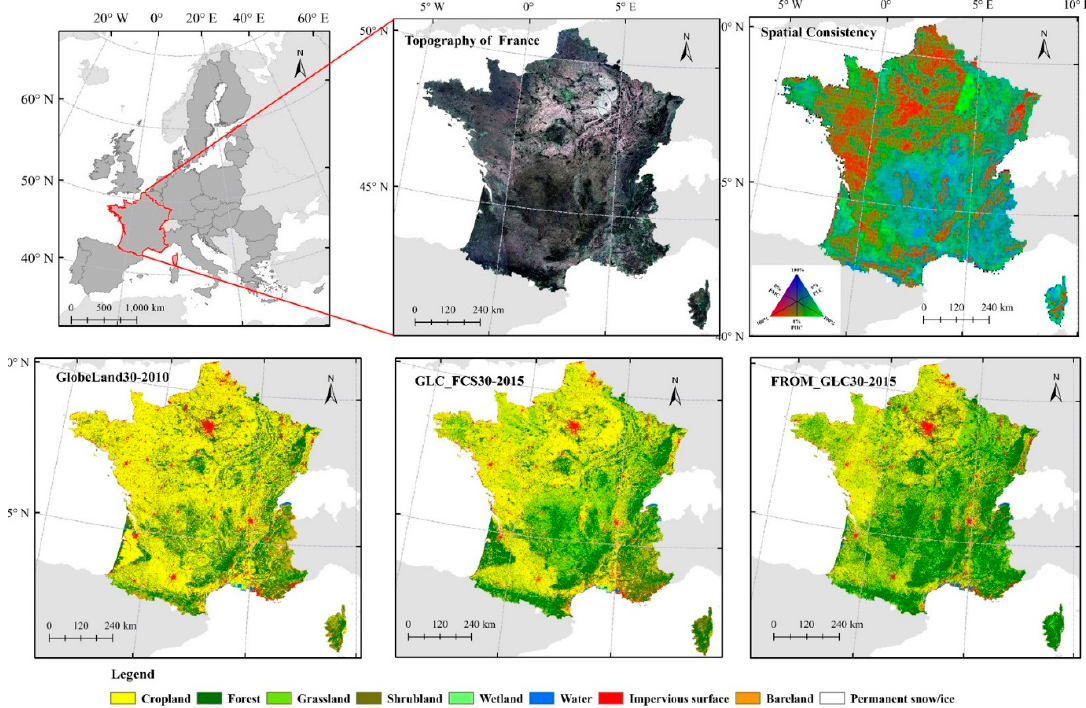
Figure 7. Spatial distribution of classes and consistency between the three GLC products within France.